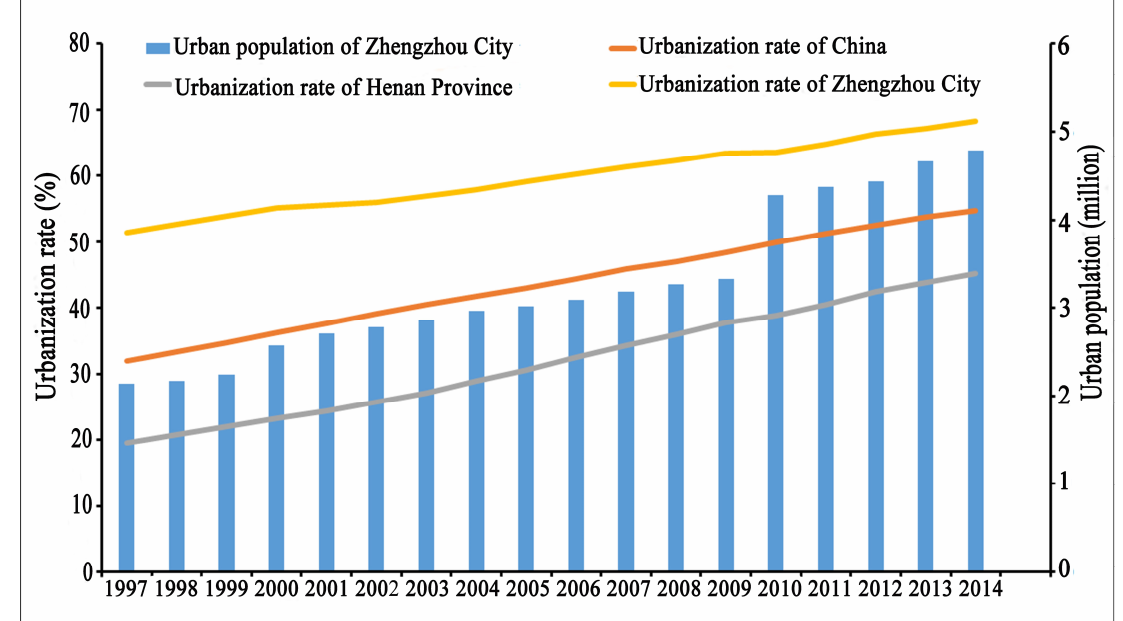
Figure 7. Urbanization rate and population growth of Zhengzhou